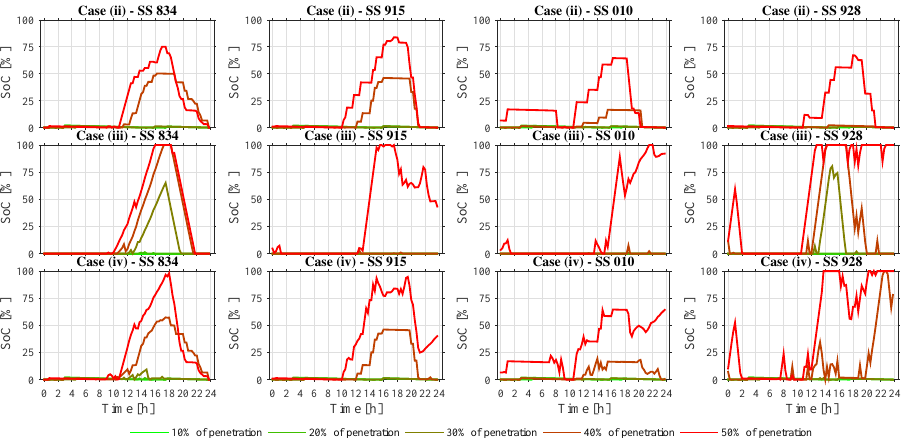
Figure 8. SoC of BESSs at SS 834, SS 915, SS 010 , SS 928 for cases (ii) to (iv) (rows) and for all DG penetrations (colour scale).